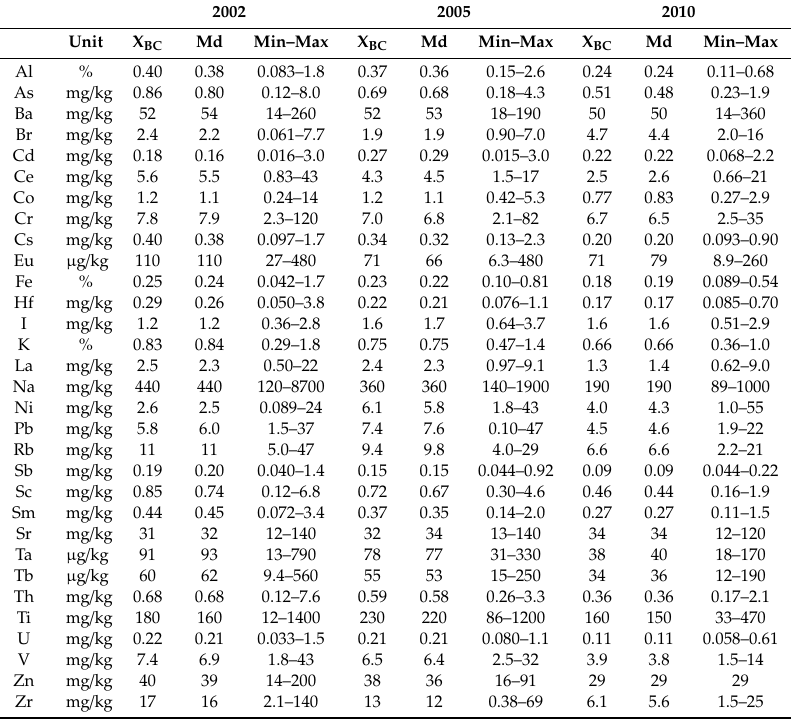
Table 2. Statistical tests of di ff erences and enrichment ratios according to sampling campaign (2002 / 2005 / 2010). Box-Cox transformed values were used for the analysis ( n = 72).